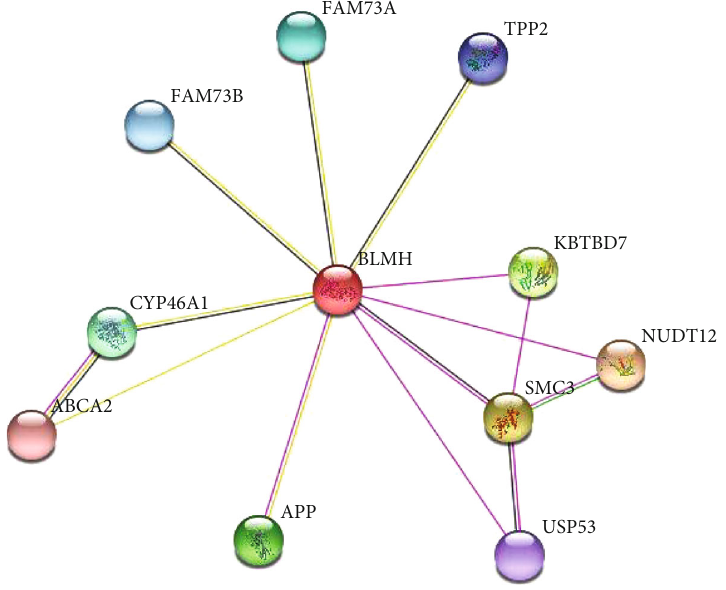
Figure 1: BMHV structure and computational domain Table 1: Comparison of the MHV dysfunction model.